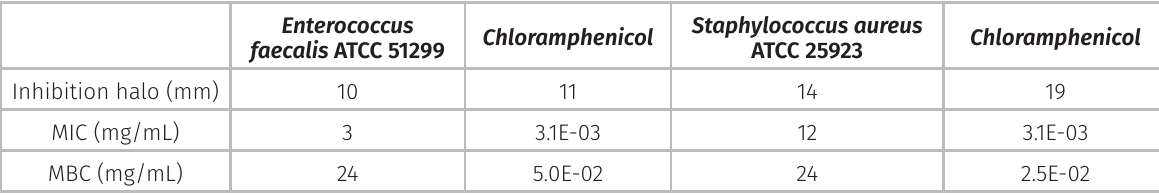
Table III. Antibacterial activity of the HCR EO against E. faecalis and S. aureus